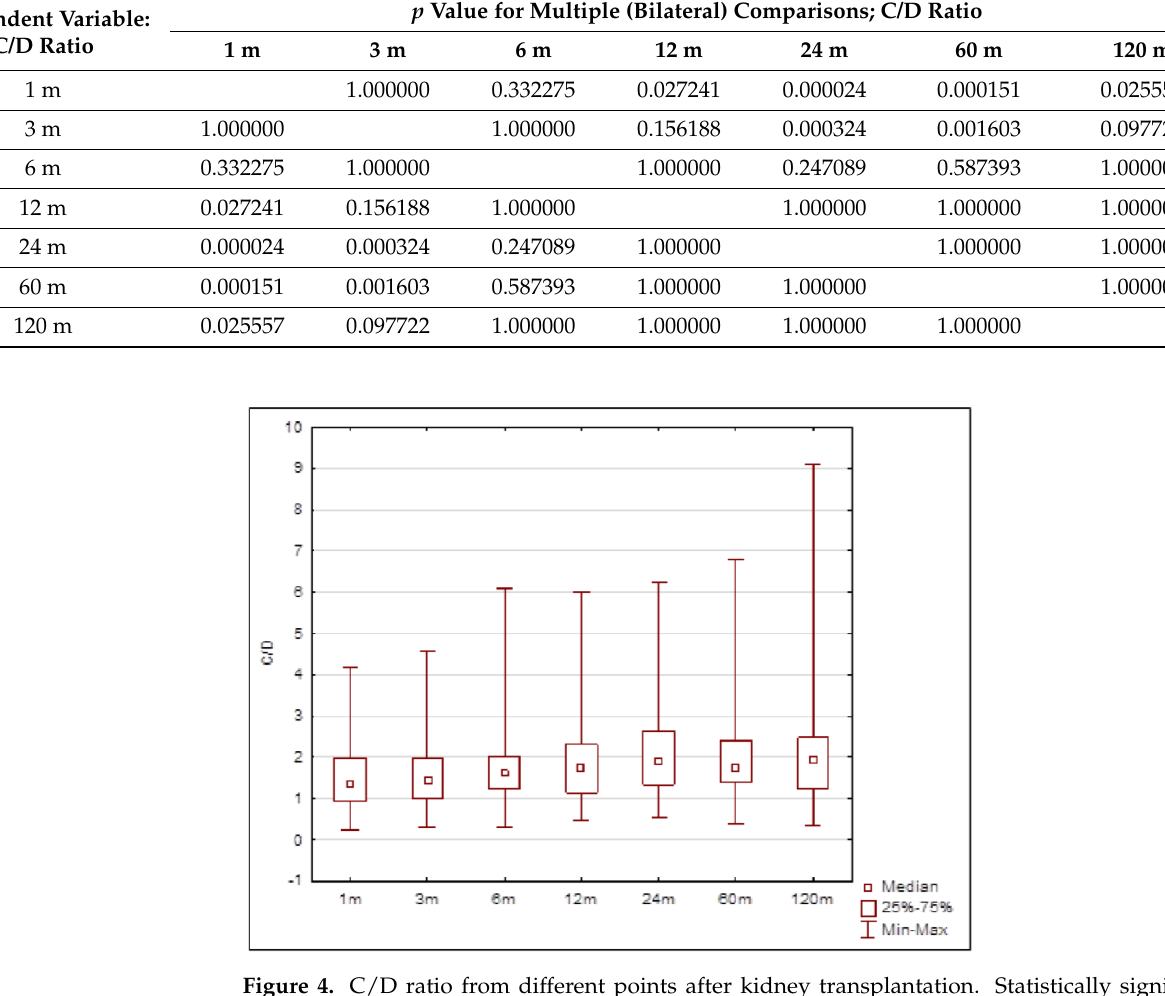
Table 3. The Kruskal–Wallis test and post hoc analysis assessing the differences in C/D ratio distribution between different points after kidney transplantation.